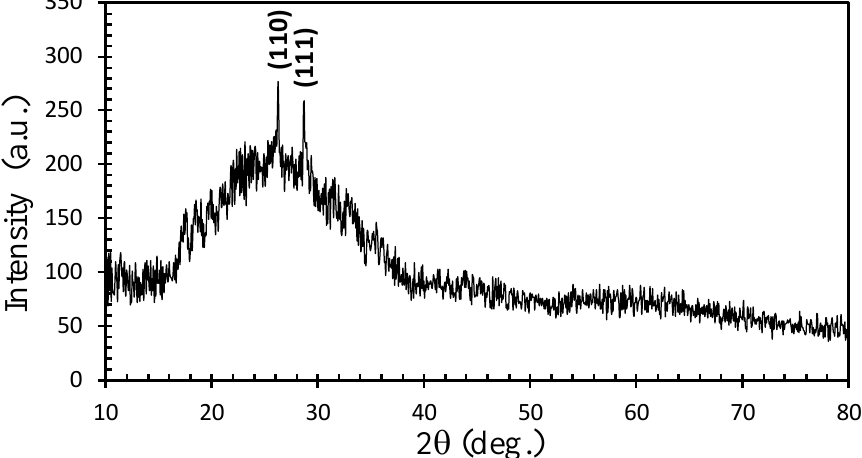
Figure 1: The XRD pattern of the thin film iron sulfide was obtained at 200 °C showing a marcasite and pyrite